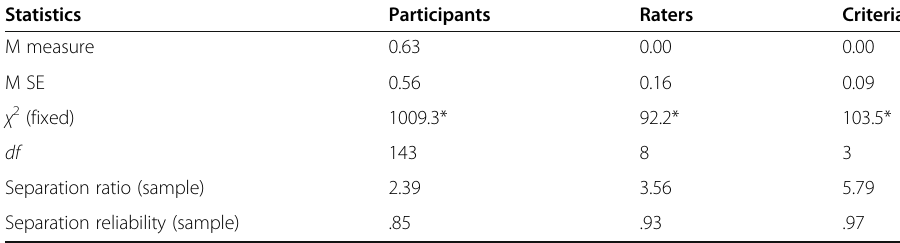
Table 5 Summary statistics for the MFRM analysis of the combined rating scale